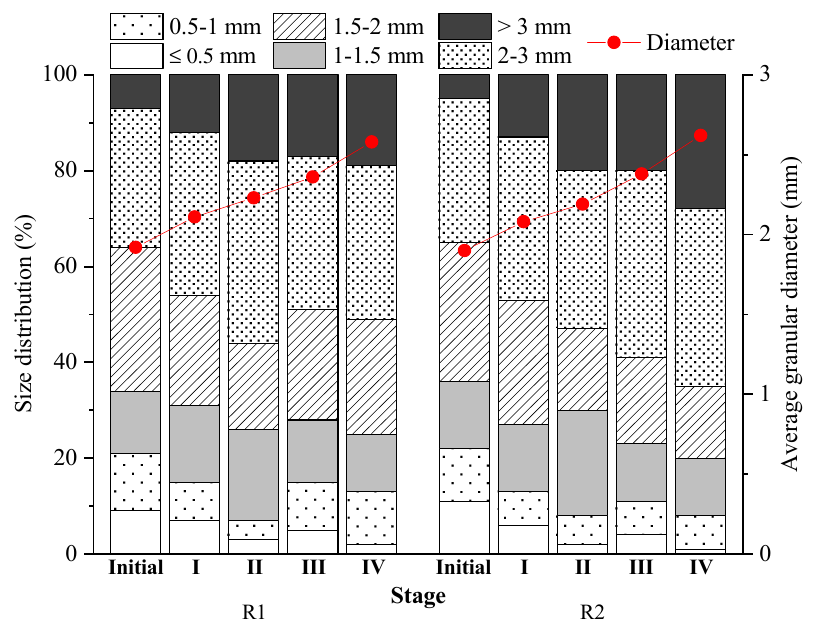
Figure 2. Changes in the diameter and its size distribution of algal-bacterial AGS in R1 and R2.